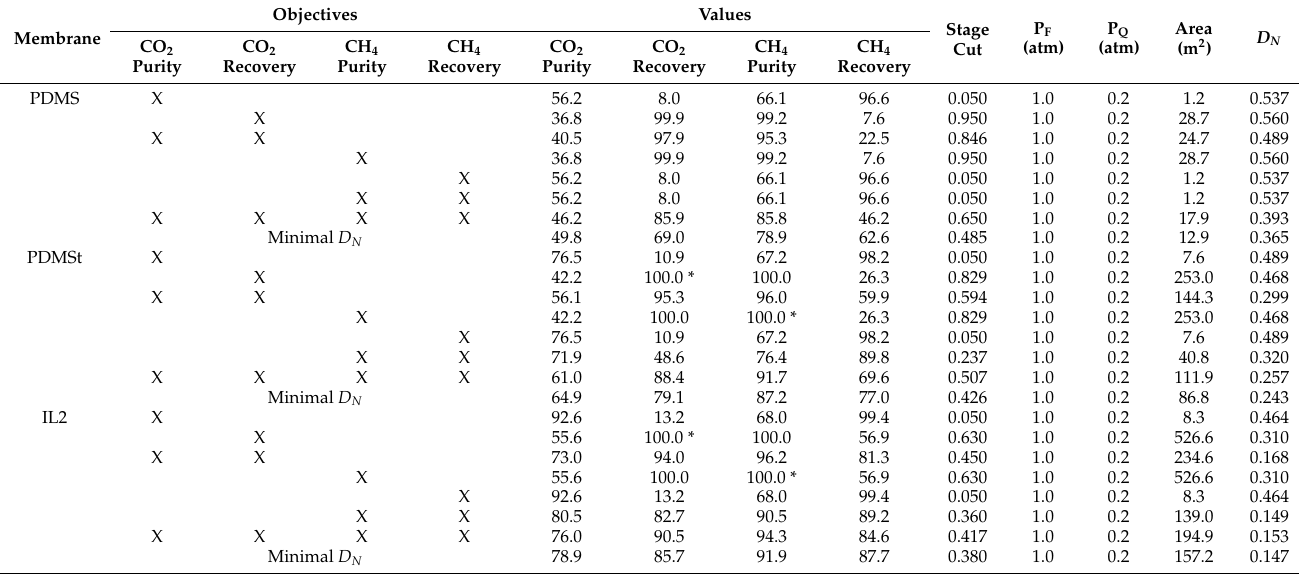
Table 3. Process performance parameters under optimal conditions (considering different objectives) of the PDMS, PDMSt and IL2 membranes (vacuum permeate at 0.2 atm).